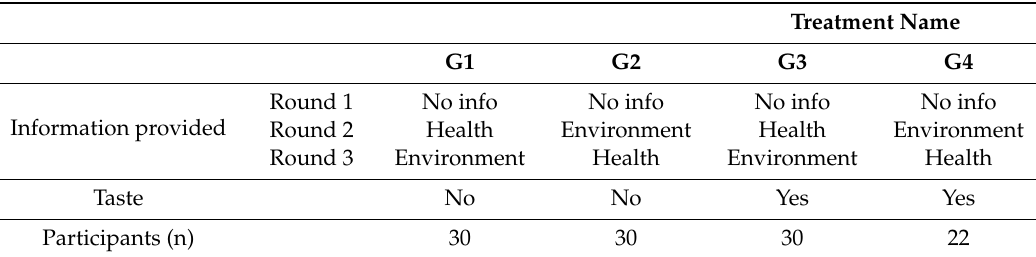
Table A2. Experimental